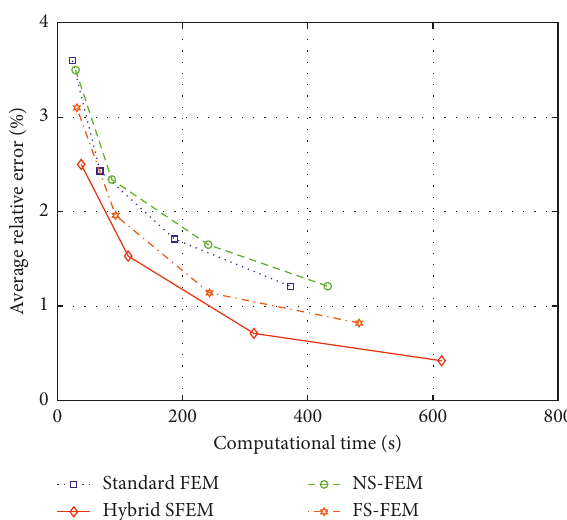
Figure 7: Frequency responses of different methods from 100Hz to 300Hz. Figure 8: Convergence curves for different